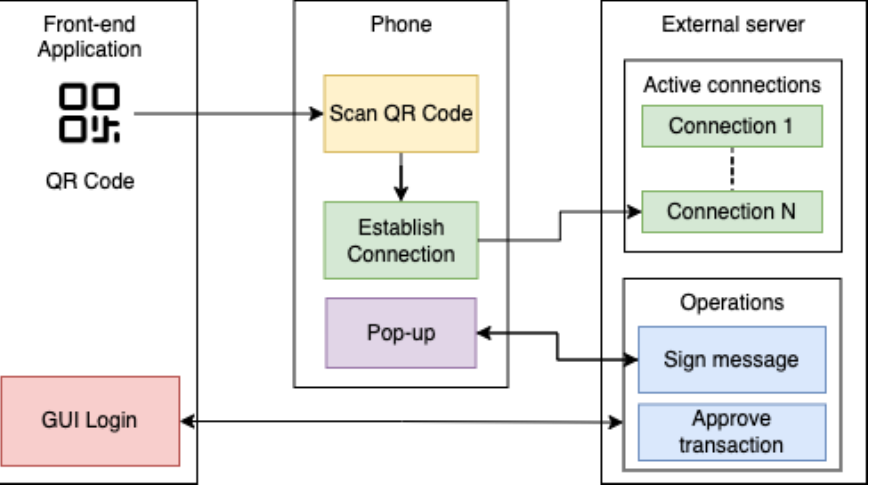
Figure 2. Mobile phone wallet interaction